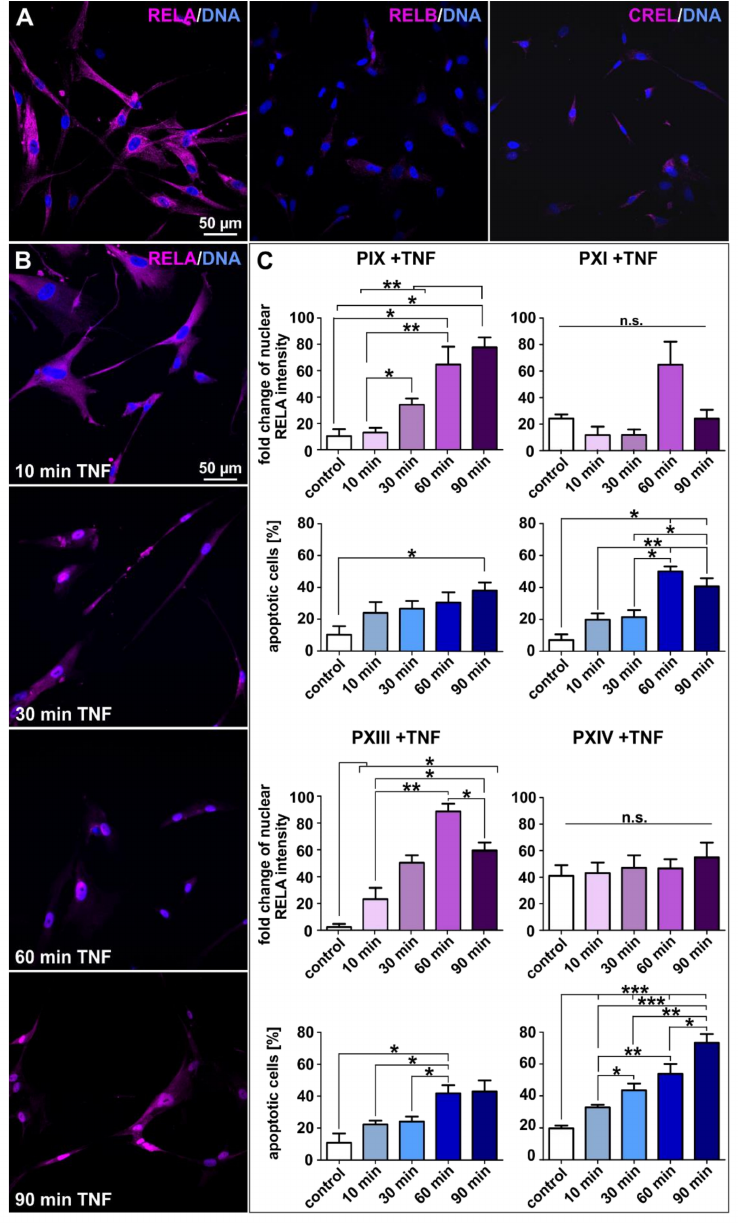
Figure 8. Tumor necrosis factor treatment led to profound cytotoxicity in prostate cancer stem cells unable to activate NF- κ B. ( A ) The exemplary immunostaining of cultured PXIV prostate cancer stem cells (PCSCs) resulted in predominant NF- κ B RELA expressions as well as slightly detectable RELB and CREL proteins expressions. ( B ) Exemplary images of immunocytochemically NF- κ B RELA-stained PXIII PCSCs after treatment with tumor necrosis factor alpha (TNF α ) for 10, 30, 60 and 90 min. The expressions of RELA in PCSCs seemed to shift from the cytoplasm to nucleus over the experimental duration. Nuclear counterstaining was performed using DAPI. ( C ) TNF α stimulations were evaluated by measuring the fold changes in nuclear RELA intensities and average percentages of apoptotic cells via quantification with ImageJ software (NIH, Bethesda, MD, USA). The PIX and PXIII PCSC populations displayed statistically significant upregulated fold changes of nuclear RELA intensities upon TNF α treatment (left panel, magenta graphs). The DAPI staining of nuclei displayed statistically high upregulations of apoptotic cells in PXI and PXIV PCSCs after treatment with TNF α (right panel, blue graphs). Statistical analysis was performed using Mann–Whitney U tests (minimum 50 cells per condition and population); * p ≤ 0.05, ** p ≤ 0.01 and *** p ≤ 0.001 were considered significant. Mean ± standard error of the mean